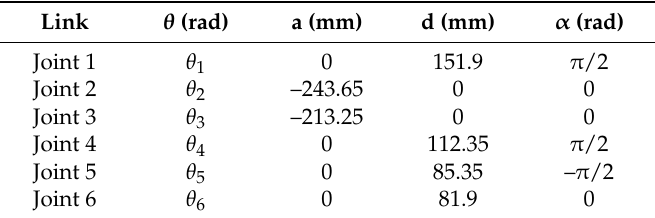
Table 1. Denavit-Hartenberg (D-H) parameters for the UR3 robot.